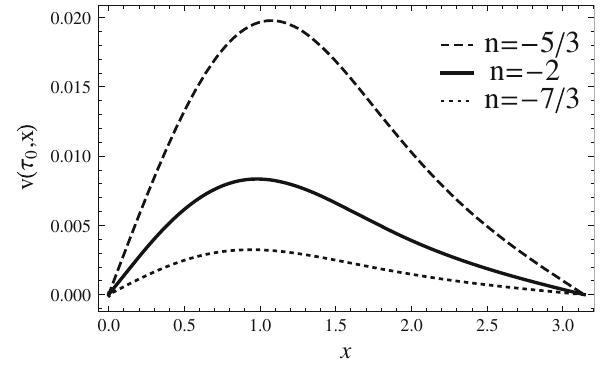
Fig. 8 Energy density (cid:3)(τ, x )/(cid:3) c versus τ plot at x = 0 fm with dif- ferent values of n . The dashed, solid and dotted curves correspond to n = − 5 / 3 , − 2 and − 7 / 3,